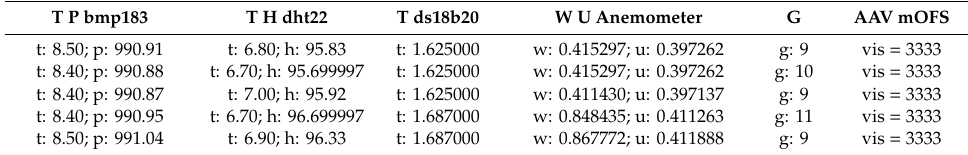
Table 3. Examples of input variables for X.